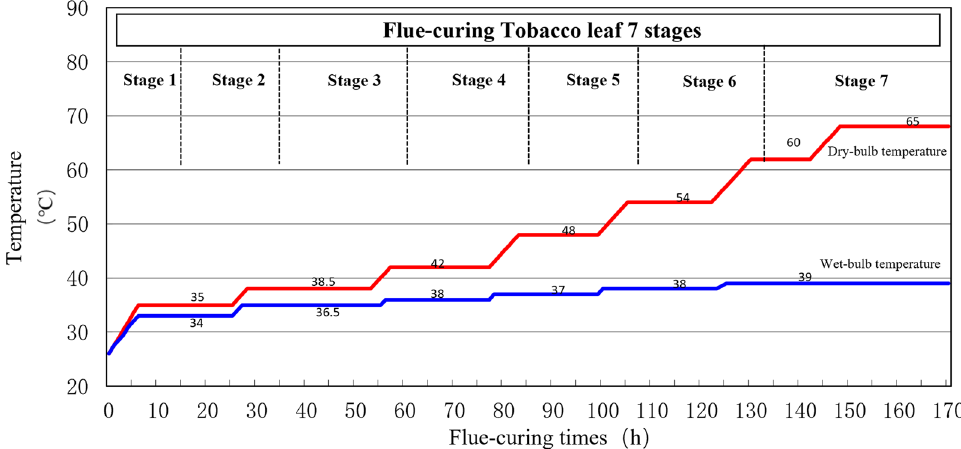
Figure 1. Conventional flue-curing procedure (CT) used in the bulk curing barns in Yuxi tobacco-growing